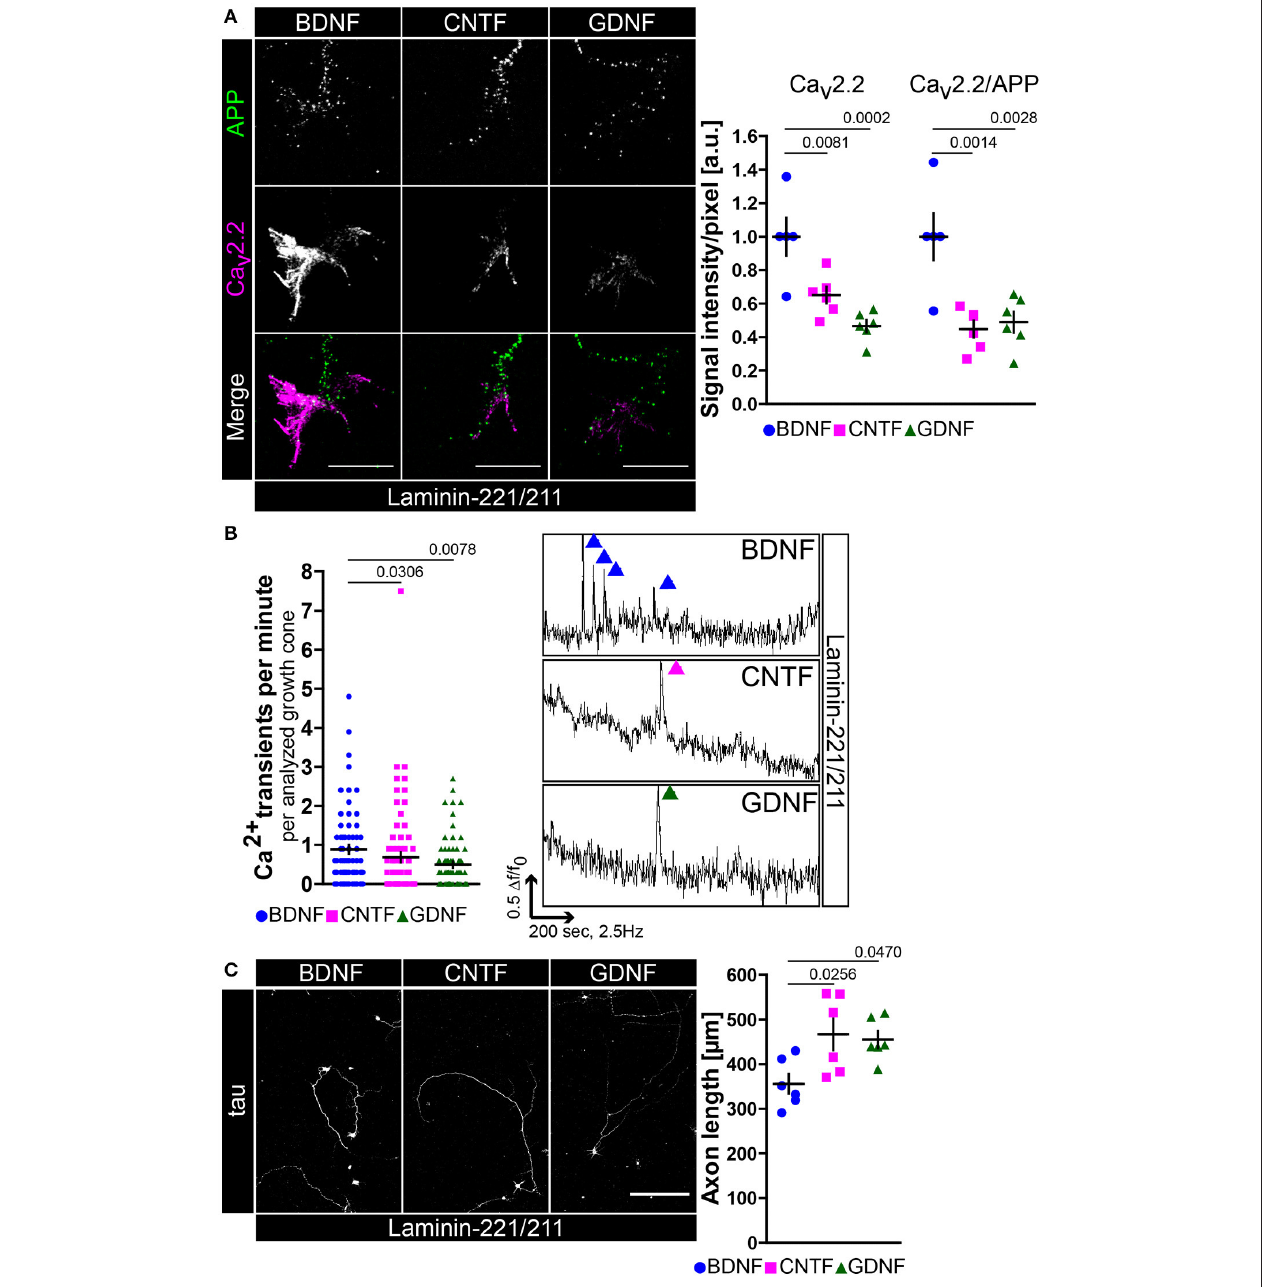
FIGURE 2 | BDNF is necessary for Ca v 2.2 accumulation and local Ca 2 + transients in growth cones of motor axons on laminin-221. (A) Images of axonal growth cones of wild type motoneurons cultured on laminin-221/211 for 5 days in vitro in the presence of BDNF, CNTF, or GDNF and stained against transmembrane protein APP (green) and Ca v 2.2 (magenta) (scale bar: 5 µ m). With CNTF or GDNF Ca v 2.2 signals were significantly reduced in comparison to BDNF (BDNF 1.00 ± 0.11, Q 2 1.00, n = 5, N = 130; CNTF 0.65 ± 0.05, Q 2 0.65, n = 6, N = 133; GDNF 0.47 ± 0.04, Q 2 0.47, n = 6, N = 145; p(B-C) = 0.0081, p(B-G) = 0.0002), particularly at axon terminal protrusions, whereas APP immunoreactivities were not decreased. Similar results were obtained by normalizing Ca v 2.2 intensities against internal reference protein APP. (B) In comparison to BDNF-treated motoneurons CNTF- and GDNF-treated cells displayed reduced frequencies of spontaneous Ca 2 + transients in their corresponding growth cones (BDNF 0.89 ± 0.11, Q 2 0.6, N = 75; CNTF 0.69 ± 0.13, Q 2 0.3, N = 77; GDNF 0.50 ± 0.08, Q 2 0.3, N = 73; p(B-C) = 0.0306, p(B-G) = 0.0078). (Right panel) Representative recordings of axonal growth cones of motoneurons cultured with BDNF (blue), CNTF (magenta) or GDNF (green) showing calcium spikes. (C) Motoneurons were cultured on laminin-221/211 for 7 days in vitro in the presence of BDNF, CNTF, or GDNF and stained against tau (scale bar: 150 µ m). Both CNTF- (466.6 ± 35.41 µ m, Q 2 465.6 µ m, n = 6, N = 263) and GDNF-treated (454.8 ± 19.28 µ m, Q 2 440.9 µ m, n = 6, N = 200) motoneurons grew significantly longer axons (p(B-C) = 0.0256, p(B-G) = 0.0470) in comparison to BDNF-treated cells (356 ± 22.16 µ m, Q 2 342 µ m, n = 6, N = 275).